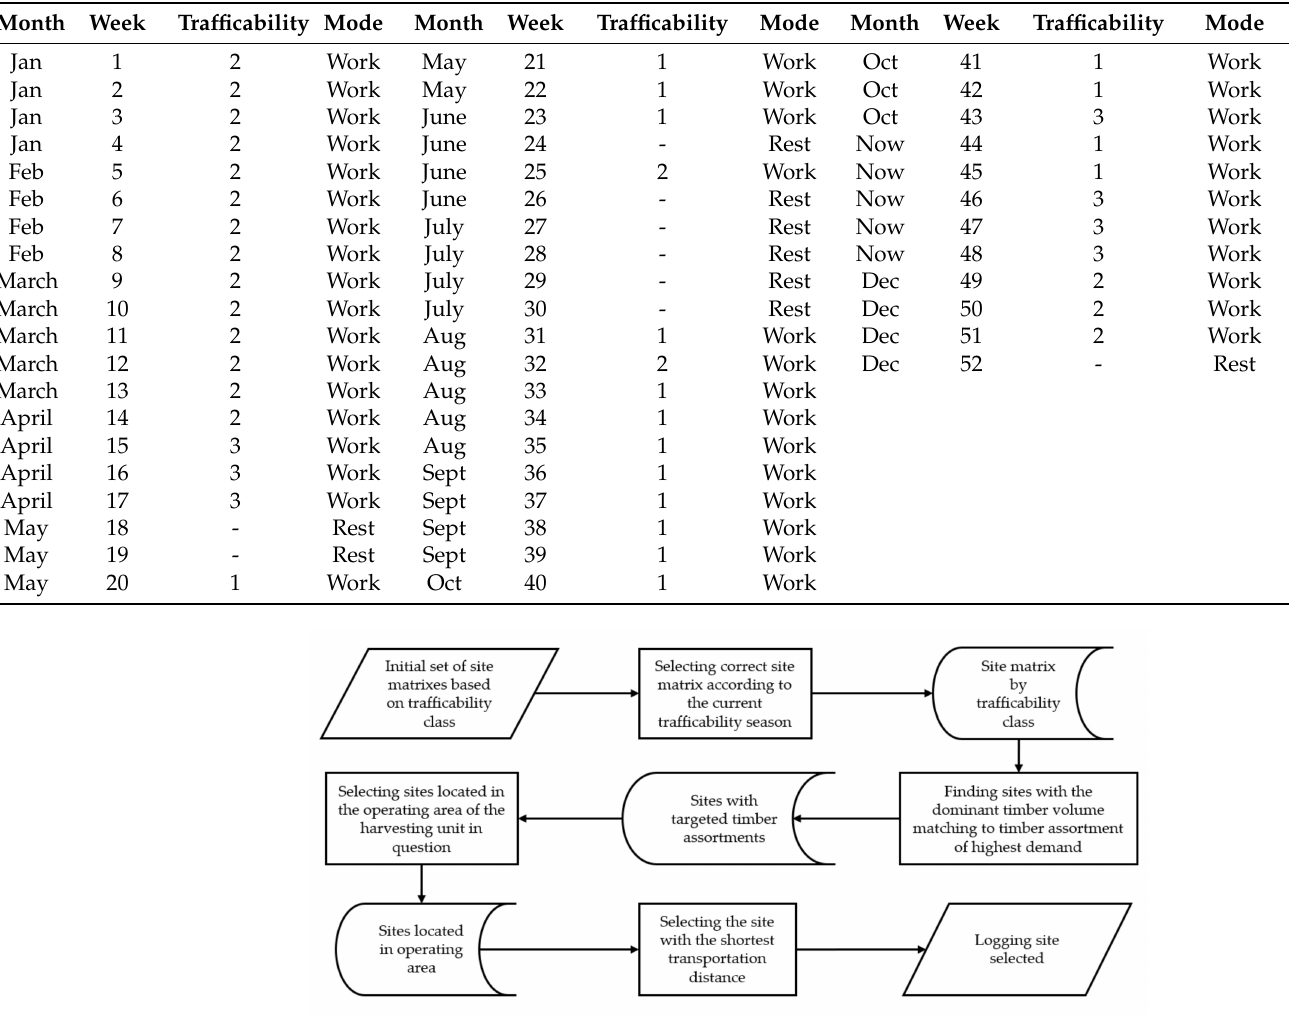
Table 6. Harvesting trafficability and rest times by week in the simulations. Harvesting trafficability indexes: 1 = summer sites, 2 = winter and dry summer sites, and 3 = thaw season sites. “Work” corresponds to the normal work week and “Rest” to lay-down times (e.g., holiday seasons).